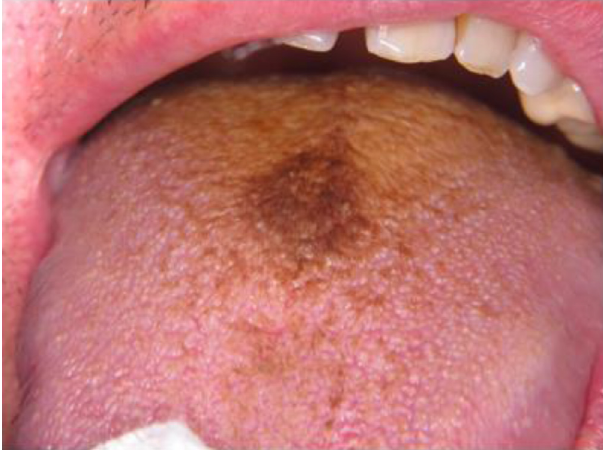
Fig. 1. Lingual tumor with a purplish appearance during the initial consultation at the Univeristy Hospital Center of Bordeaux. Fig. 2. Healing on the tongue, 1 month after the surgery.